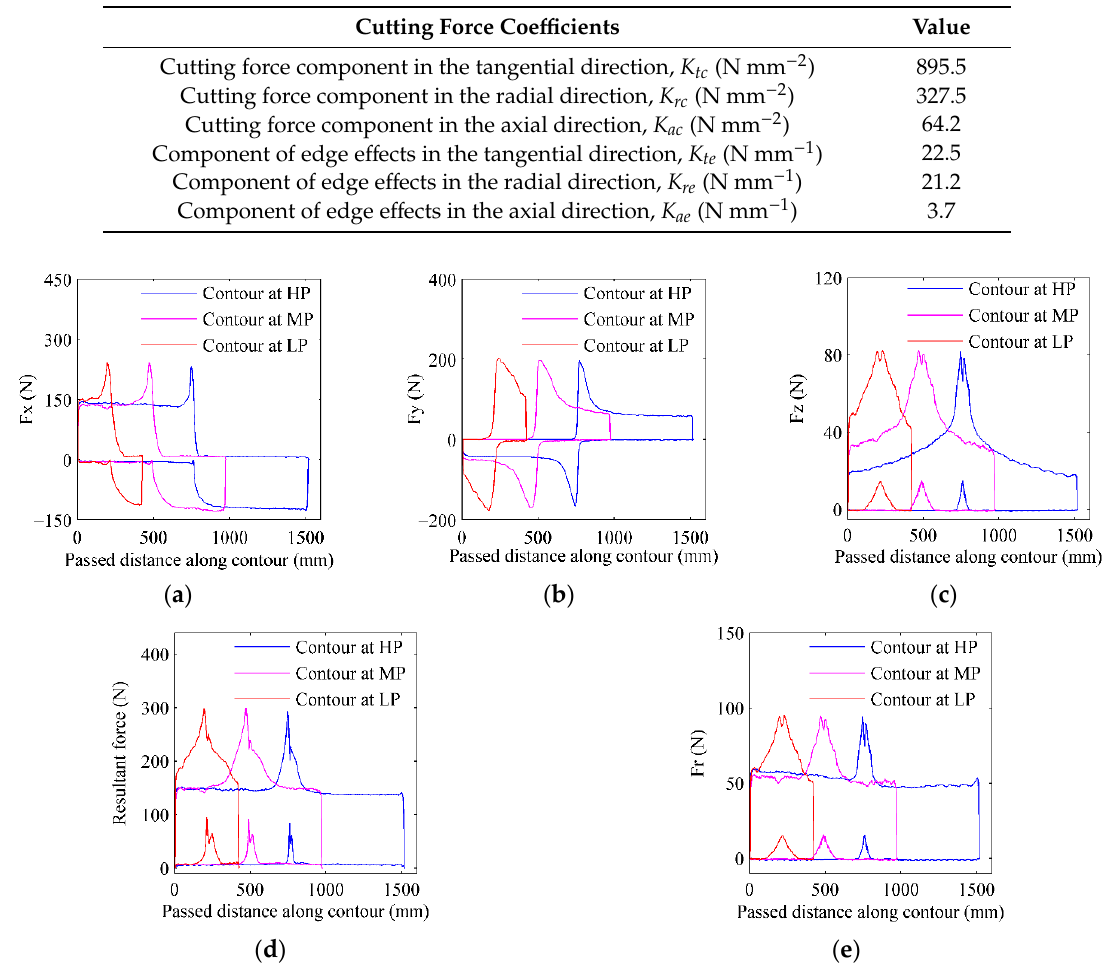
Figure 5. Simulated cutting force along the contour from different heights: ( a ) cutting force in the X w ‐ direction; ( b ) cutting force in the Y w ‐ direction; ( c ) cutting force in the Z w ‐ direction; ( d ) resultant cutting force; ( e ) radial cutting force of the ball head endmill cutter.